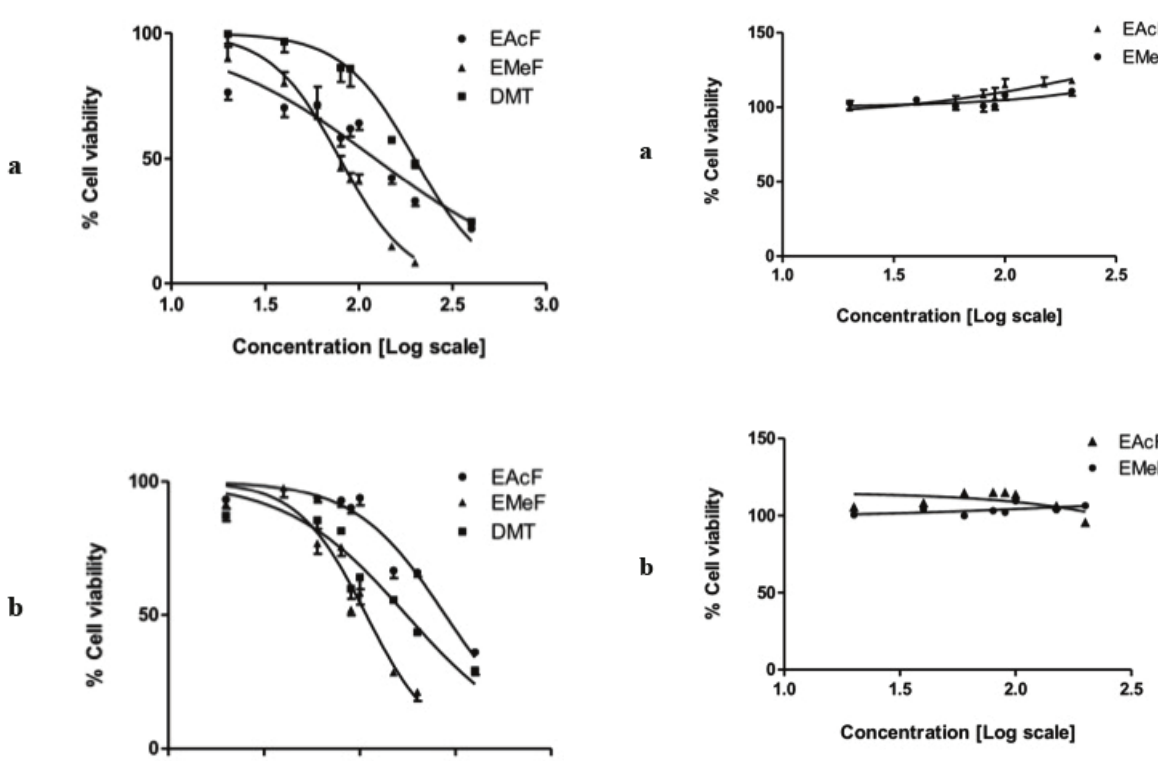
Figure 3 - Representative curves of surviving BHK-21 (A) and CHO cells (B) versus log of concentration (µg/mL) of EAcF and EMeF extracts from leaves of P. viridis . The IC50 value was not determined in the concentration range used (n =